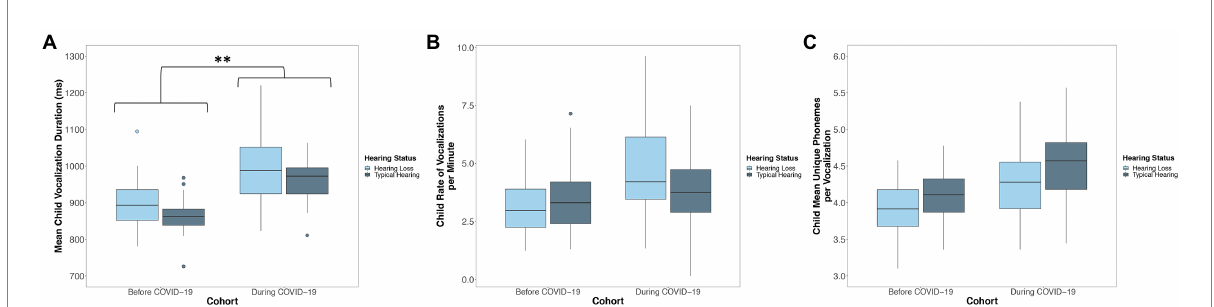
FIGURE 3 Distribution of the (A) mean duration, (B) rate of vocalizations per minute, and (C) phonemic diversity of children’s language production before (Cohort 1) and during COVID-19 (Cohort 2). Boxes represent the interquartile range, horizontal lines represent medians, whiskers represent error which is 1.5 times the interquartile range, and points outside of the boxes represent outliers outside of this range. Asterisks represent significant differences related to Cohort. * p < 0.05, ** p < 0.01. Children observed during COVID-19 (Cohort 2) produced speech-related vocalizations that were longer in duration than children observed before COVID-19 (Cohort 1). Children with hearing loss produced speech-related vocalizations that were less phonemically diverse than their peers with typical hearing, but did not differ from their peers with typical hearing in the duration or rate of their